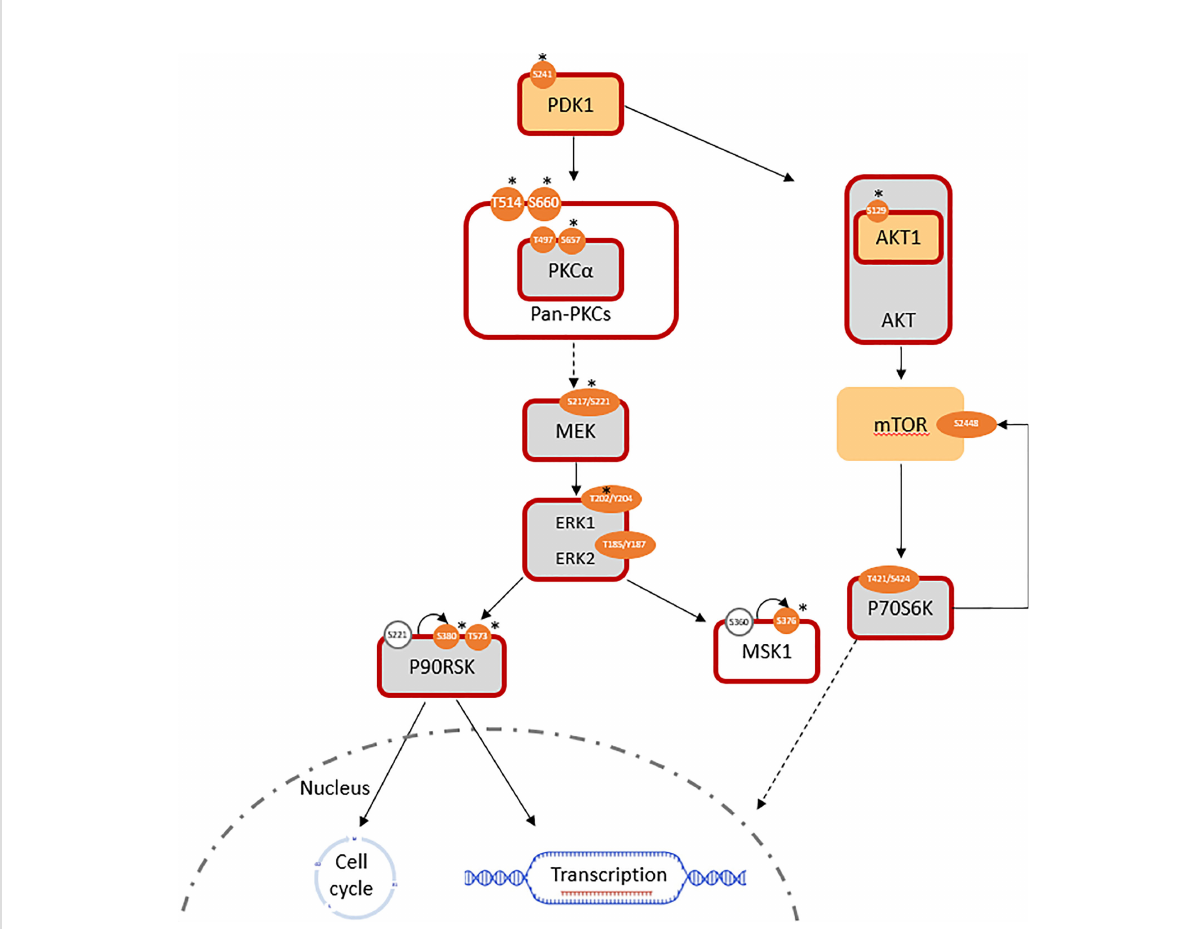
FIGURE 1 Pathways involved in the induced trastuzumab resistance of T15 (log 2 FC normalized to SKBR3 signals). Similarly expressed protein: light grey; antibody not available/poor performance: no fi ll; overexpressed total protein ≥ 1.5-fold (log 2 FC ≥ 0.58): light orange; ≥ 2-fold: *; over- represented phosphosite ≥ 1.5-fold: orange; ≥ 2-fold: *; predicted active protein: dark red